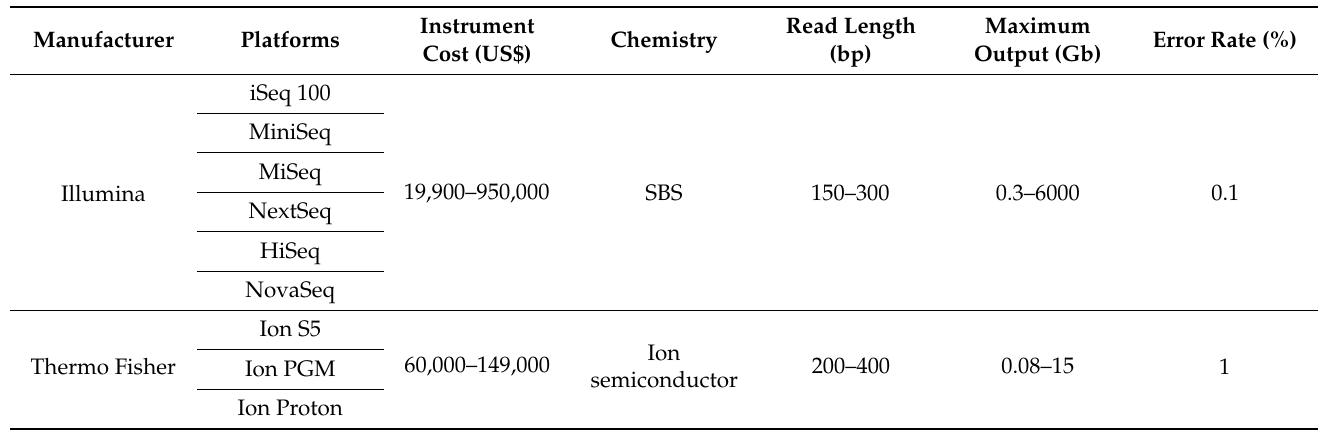
Table 1. Summary of popular NGS